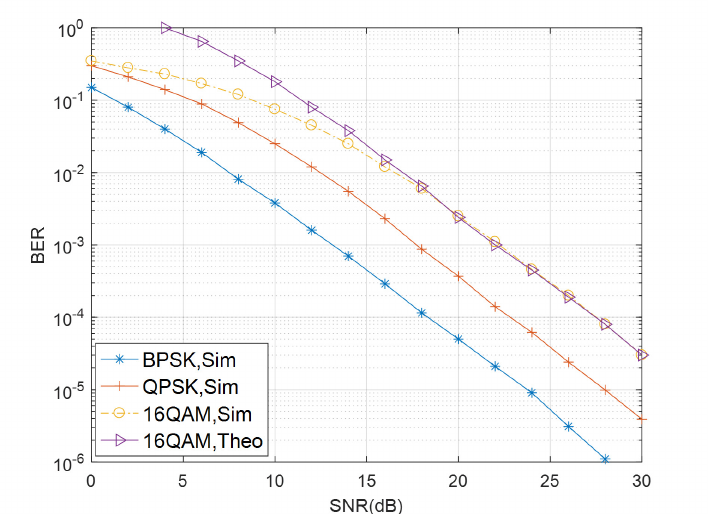
= N R = N R = N D = 4 with r r t t